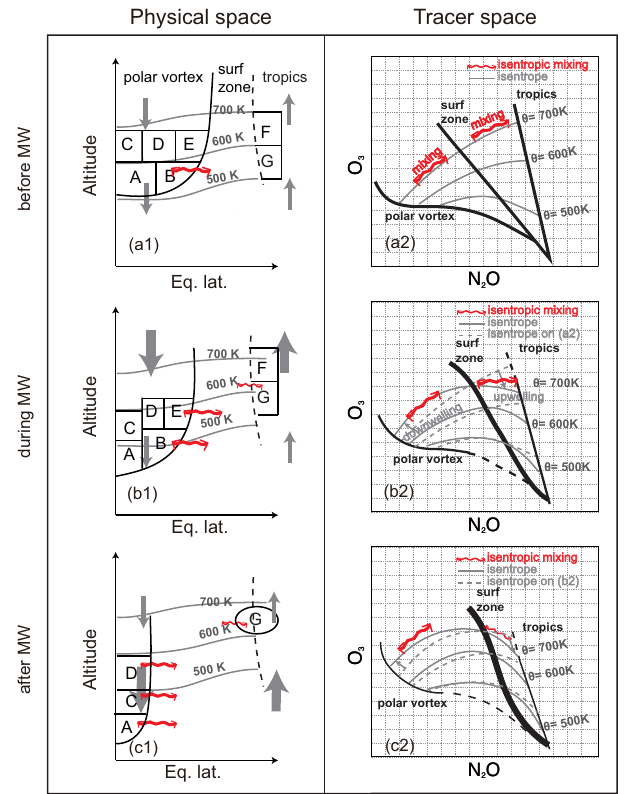
Figure 8. Schematic diagram of transport processes shown in phys- ical space (left column) and tracer space (N 2 O–O 3 , right column) before (top), during (middle) and after (bottom) the major SSW. In the physical space (left column), equivalent latitudes are used as the horizontal coordinates to illustrate isentropic mixing (curved red arrows) and cross-isentropic transport (grey vertical arrows). The thickness of the grey arrows indicates the intensity of vertical motion. The characters denote exemplarily the vortex and tropical air masses which interact with the mid-latitude air. Black curves in (a2)–(c2) show respective N 2 O–O 3 correlations. Grey lines denote the isentropic levels. In the tracer space, the position of isentropes before (dashed) and after (solid) the major SSW is also marked. The change of the position of a prescribed point in the tracer space along the isentropes quantifies isentropic mixing, whereas motion relative to these isentropes describes the effect of an idealized (mixing-free) cross-isentropic motion (up- or downwelling). Changes of the rel- ative thickness of the different correlation branches mean their en- hanced or weakened relative contributions to the composition of the considered part of the atmosphere (dashed lines indicate a possible missing